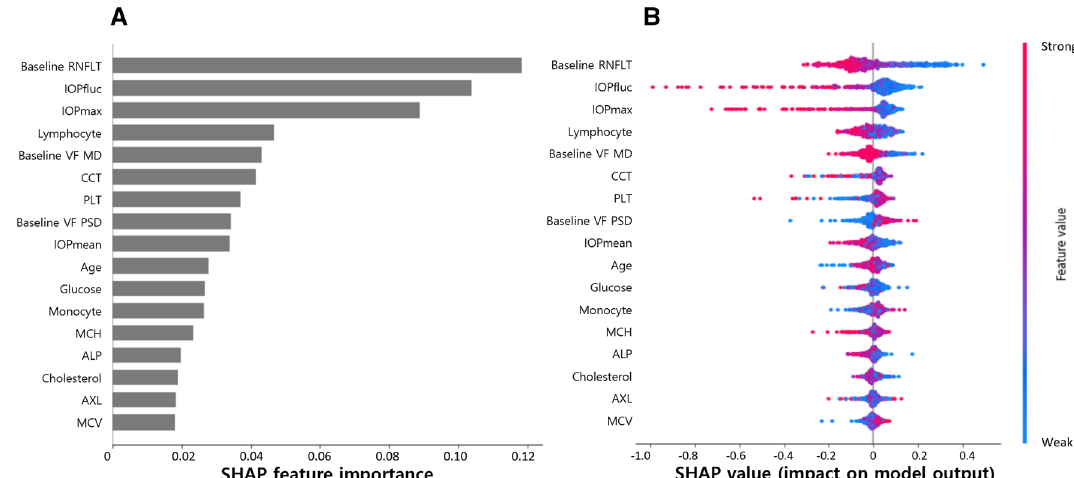
Figure 3. Interpretation of the final model based on ophthalmic and systemic variables. Feature importance plot based on mean SHAP values ( A ). Interpretation of the importance of features using the SHAP plot ( B ). The red and blue colors indicate feature values of high and low levels, respectively. For example, a larger global RNFLT had a strong, negative effect on the rate of RNFL thinning (i.e., faster RNFL thinning). SHAP SHapley Additive explanation, RNFLT retinal nerve fiber layer thickness, IOPfluc intraocular pressure fluctuation during follow-up, IOPmax maximum intraocular pressure, VF visual field, MD mean deviation, CCT central corneal thickness, PLT platelet, PSD pattern standard deviation, IOPmean mean intraocular pressure, MCH mean corpuscular hemoglobin, ALP alkaline phosphatase, AXL axial length; MCV mean corpuscular